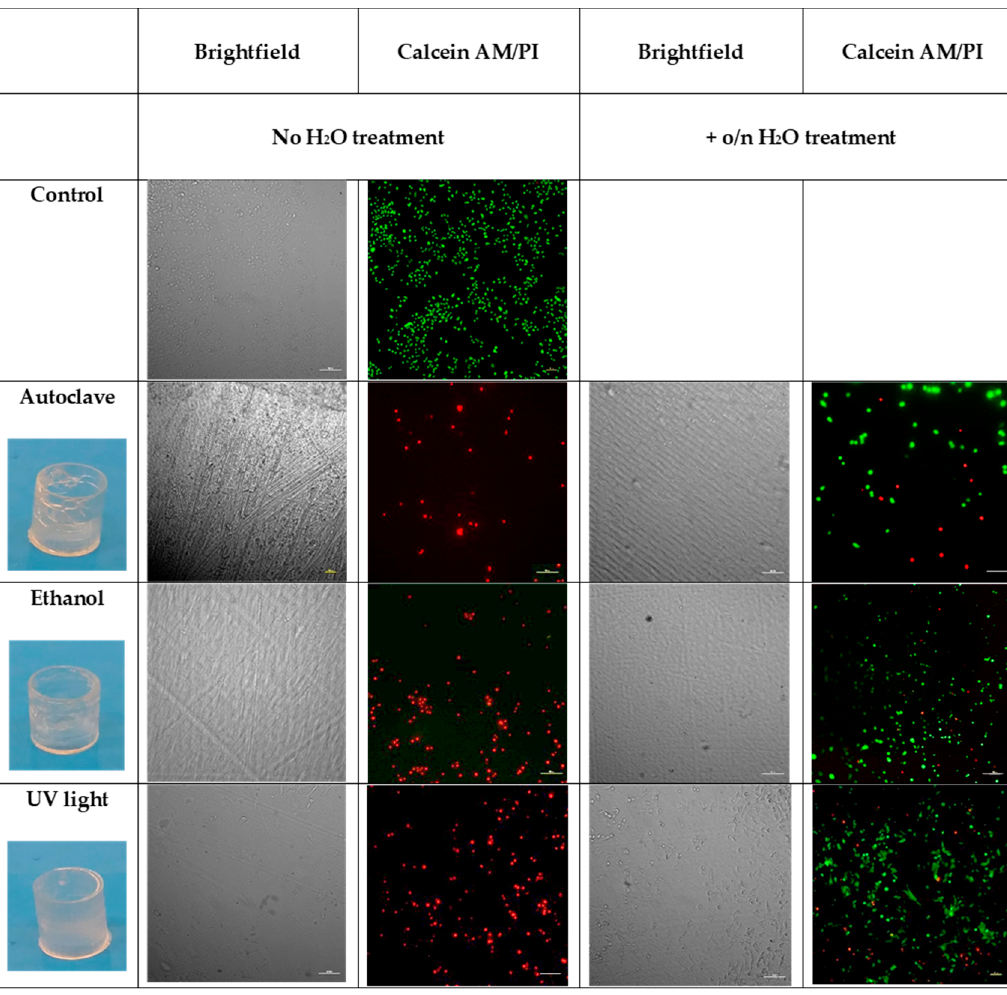
Figure 6. Images of the real 3D printed wells after the di ff erent sterilization methods. The survival status of the A549 cells on the P-0.2 3D printed wells, sterilized using autoclave, ethanol, and UV light with or without water pretreatment was evaluated by live / dead staining and phase-contrast image. The scale bar denotes 100 μ m for all images.